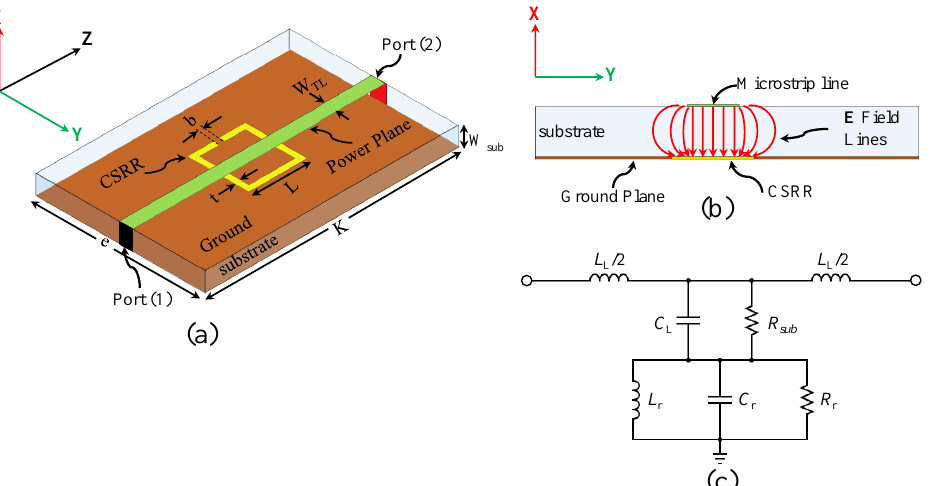
Figure 1. ( a ) The schematic of the original CSRR excited using two-port microstrip line, W sub = 0.762 mm, W TL = 1.629 mm, e = 40 mm, K = 100 mm, L = 7.5 mm, t = 0.2 mm, and b = 0.2 mm. ( b ) The cross-section of the CSRR sensor with the expected electric field lines of the quasi-TEM TL. ( c ) The circuit model of the CSRR, where L L is the inductance-per-unit length of the TL, C L is the capacitance-per-unit length of the TL, R sub is losses in the substrate, C r is the resonator’s capacitance, R r is the resonator’s resistance, and L r is the resonator’s